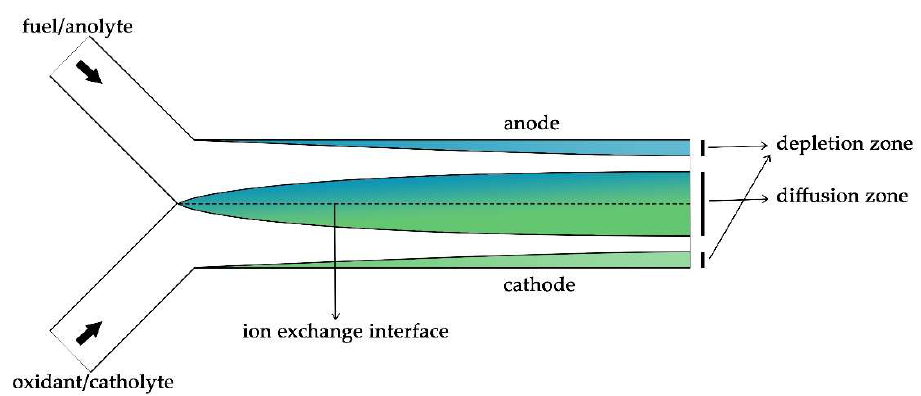
Figure 8. Representation of a laminar membraneless RFB. Adapted from Ref. [33], Copyright 2017, Elsevier.